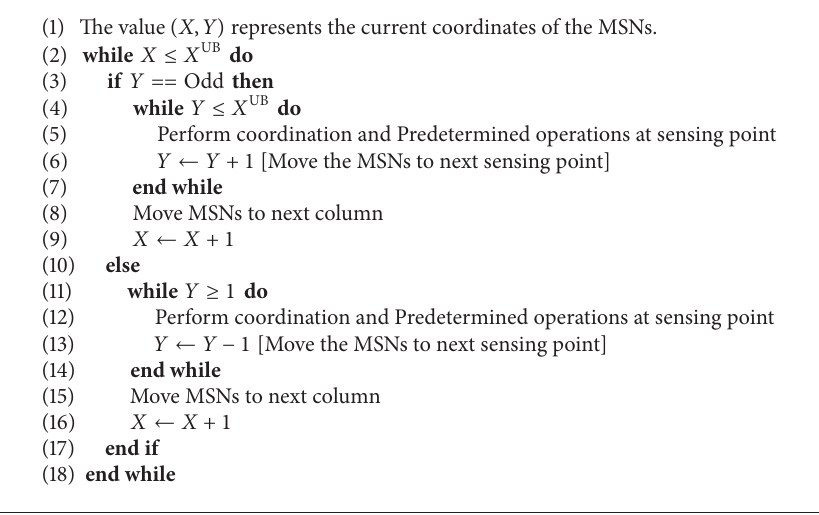
Algorithm 2: MSNs traversal algorithm—common traversal